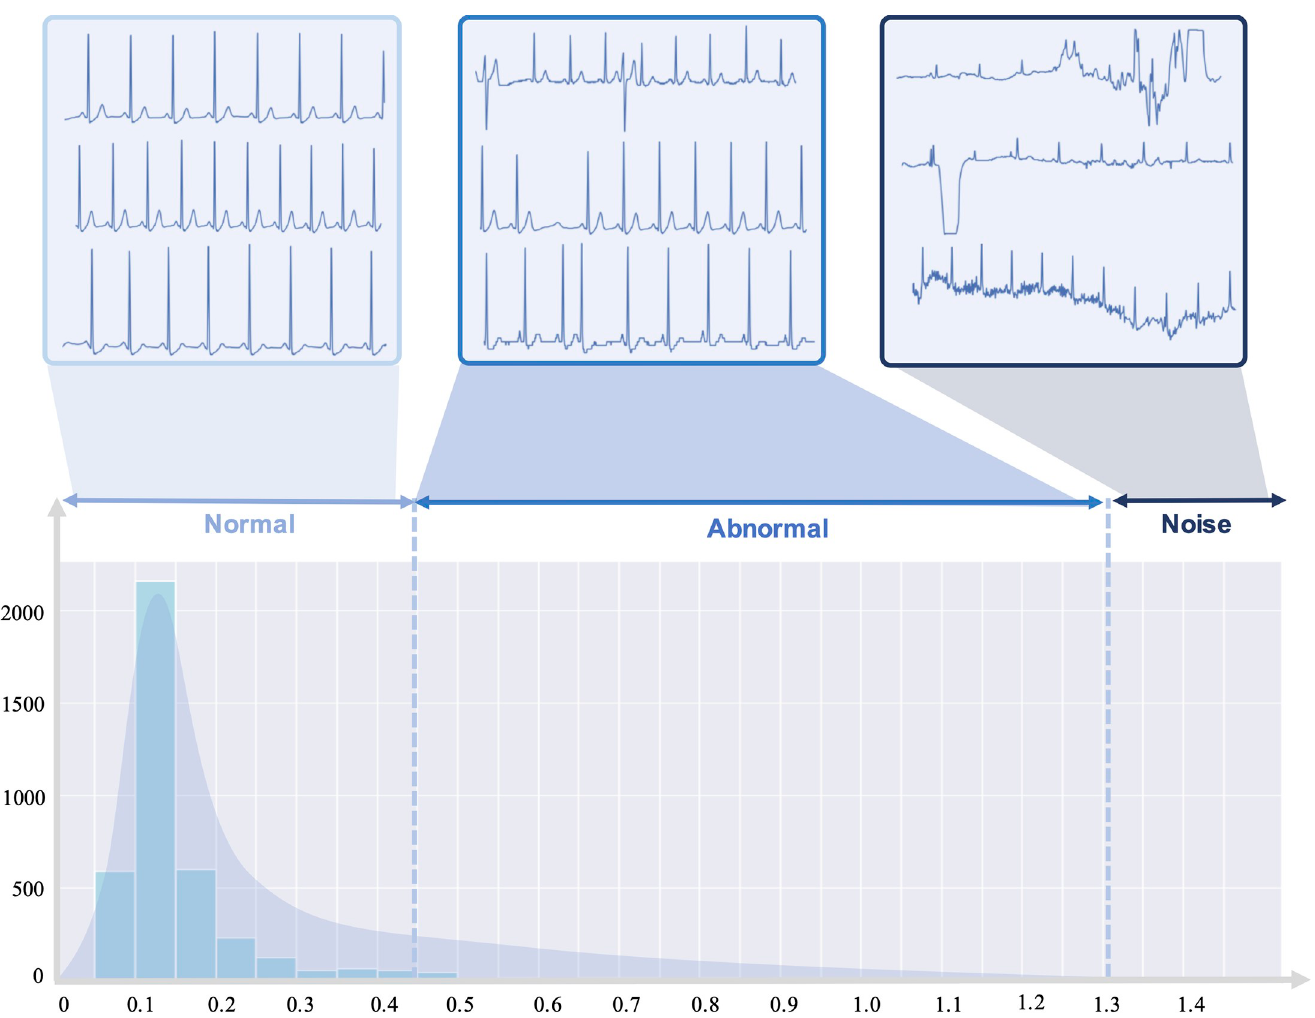
Fig 5. Distribution of anomality score in 1,000 patients. The distribution of the anomality score is skewed to the left, which is consistent with the premise that the number of normal ECGs is more than the number of abnormal ECGs. ECGs with an anomality score over 1.3 were due to noise or movement artifacts. The majority of ECGs with an anomality score between 0.45–1.3 were